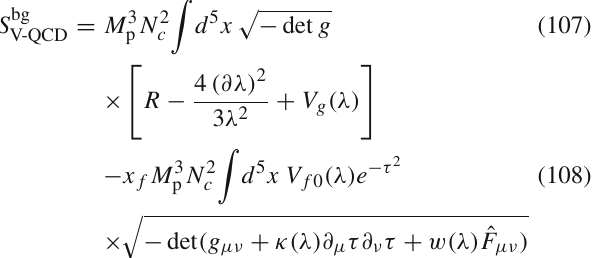
Fig. 8 Fitting w(λ) to the QCD lattice data [44] for the cumulant χ B . The red dots and error bars show the lattice data, and blue and green curves are our fits. Figure taken from [276]